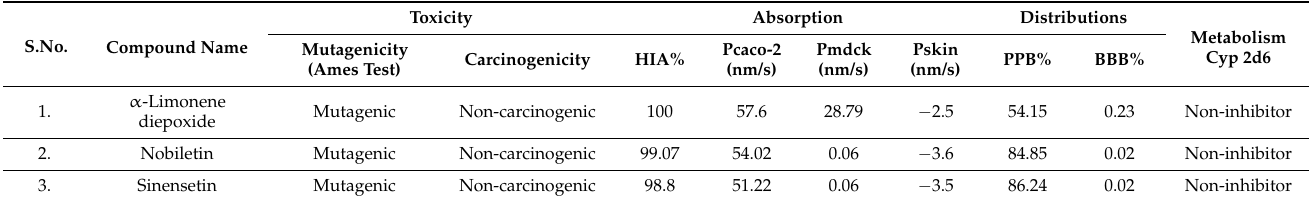
Table 2. ADMET profiling of the filtered